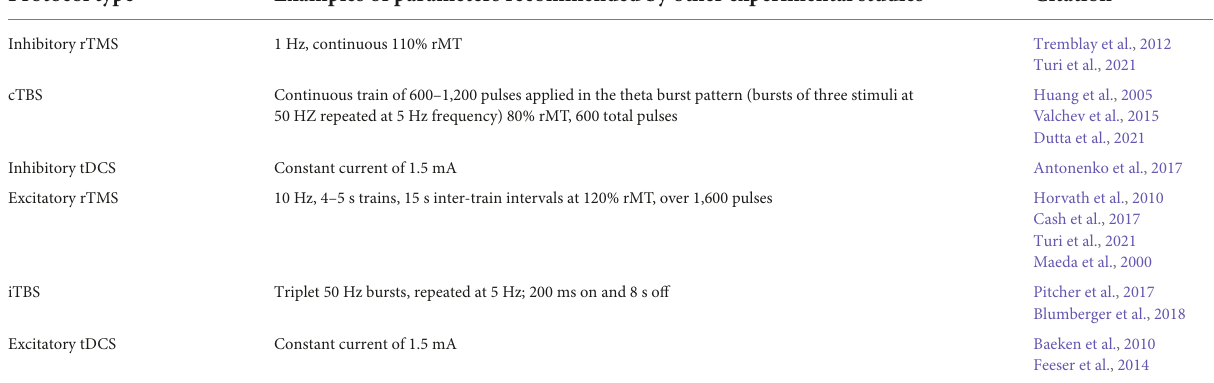
TABLE 4 Examples of specific parameters that are based on research findings or other protocols where similar goals (e.g., reducing hyperconnectivity) were accomplished for different types of neurostimulation discussed in this